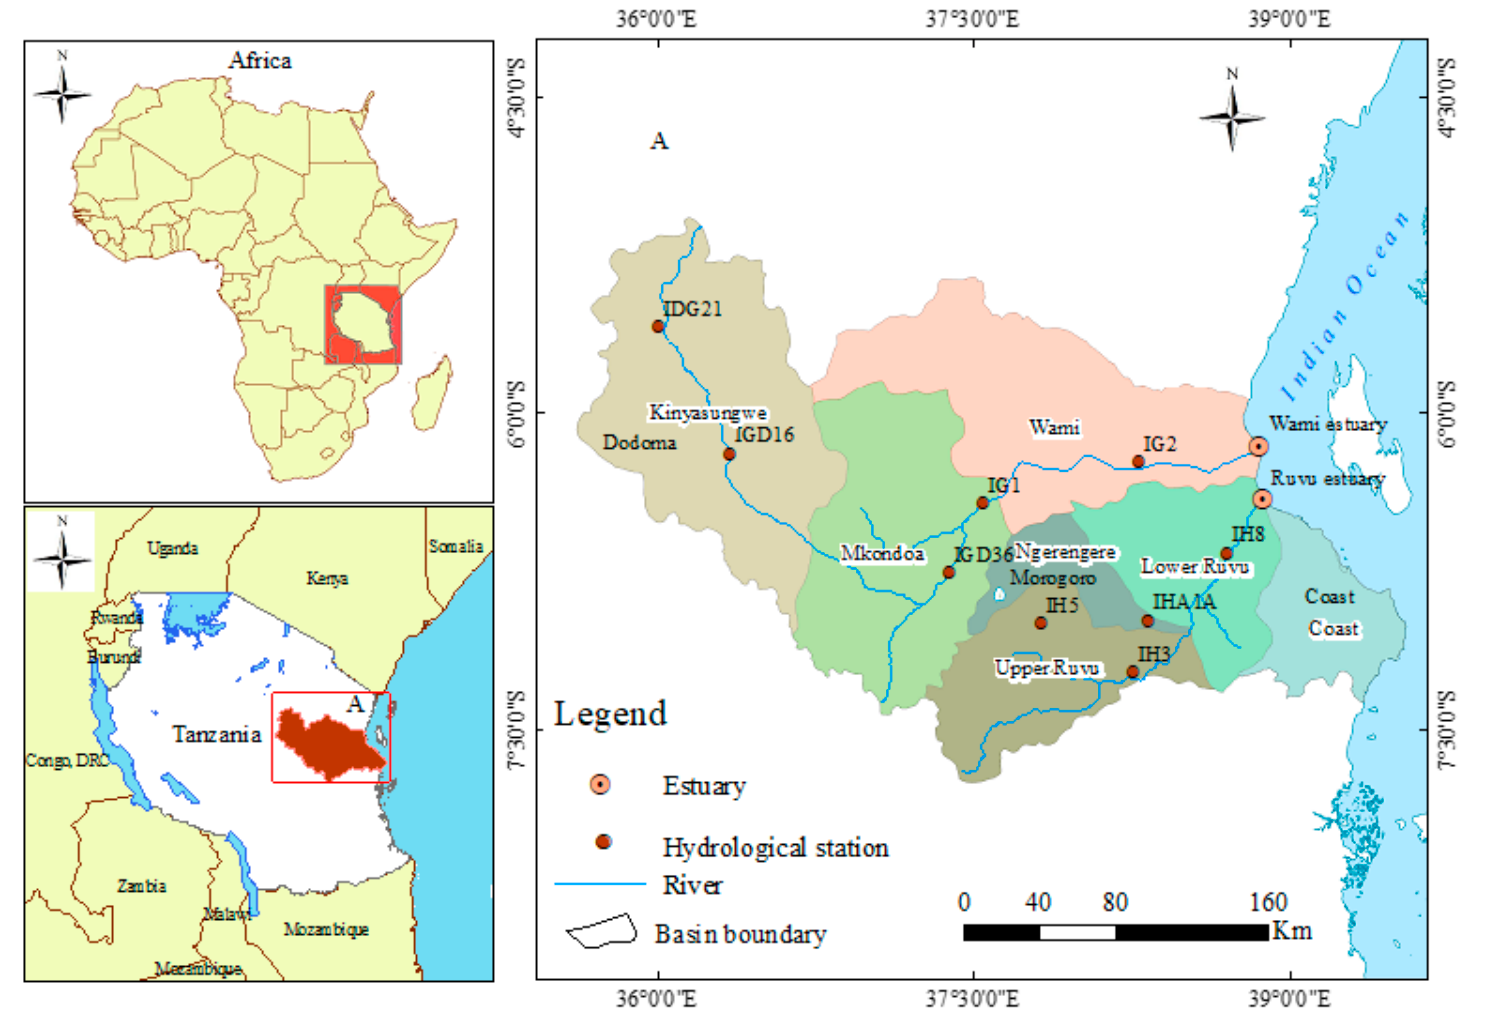
Figure 1. The location of the study area: the Wami ‒ Ruvu Basin (WRB), Tanzania.